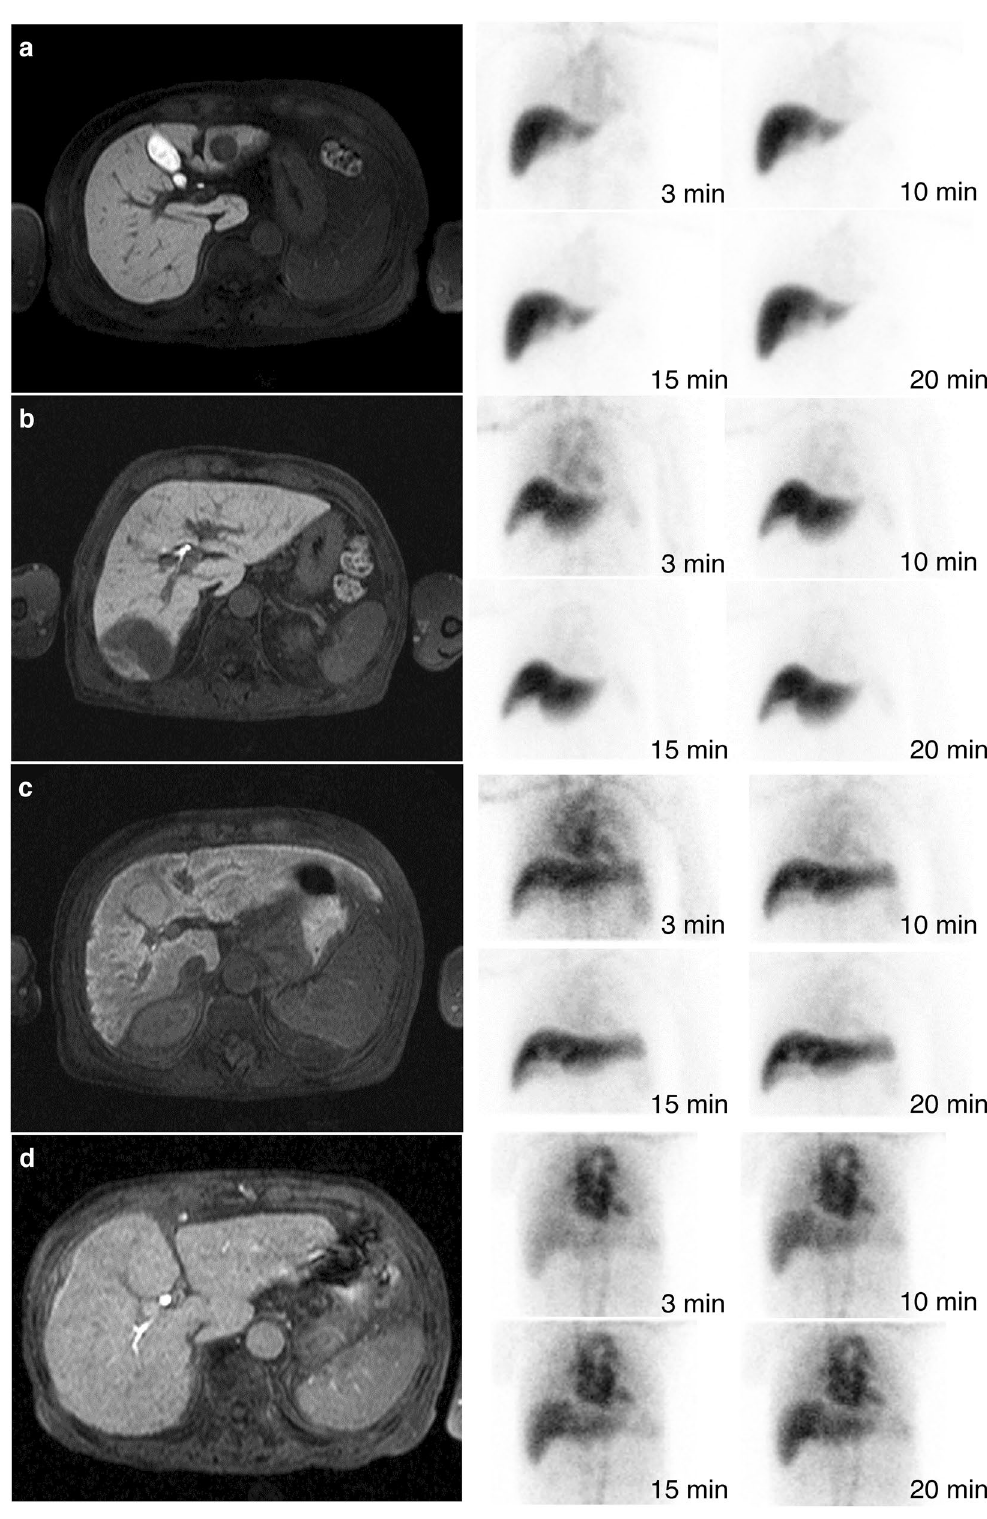
Figure 4. Reference images of various imaging-based clinical stages. The left and right image in figures are the hepatobiliary-phase images in Gd-EOB-DTPA-enhanced MRI and the planer images in 99m Tc-GSA liver scintigraphy, respectively. (a) Images of Normal stage. The LSC, eLHL15, LHL15, HH15, and ALBI score were 0.487, 0.95, 0.95, 0.61, and –2.899 (Grade 1), respectively. (b) Images of Mild stage. The LSC, eLHL15, LHL15, HH15, and ALBI score were 0.375, 0.90, 0.90, 0.61, and –2.756 (Grade 1), respectively. (c) Images of Moderate stage. The LSC, eLHL15, LHL15, HH15, and ALBI score were 0.257, 0.85, 0.84, 0.69, and –1.426 (Grade 2), respectively. (d) Images of Severe stage. The LSC, eLHL15, LHL15, HH15, and ALBI score were 0.114, 0.78, 0.65, 0.88, and –2.150 (Grade 2),